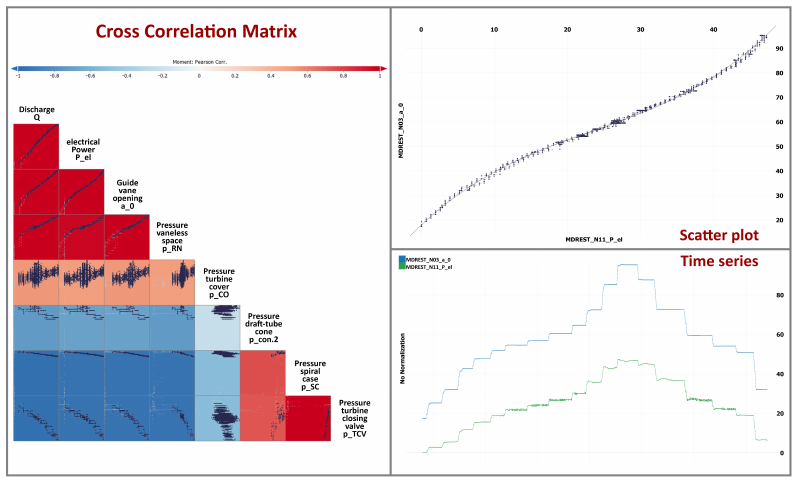
Figure 18. Data Cross Correlation for different machine diagnosis